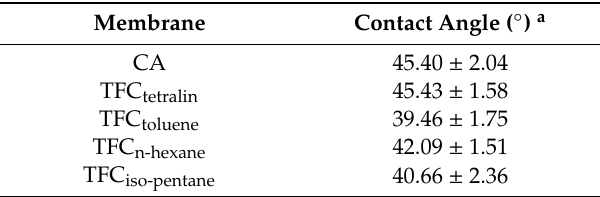
Table 3. Water contact angle of the membranes.